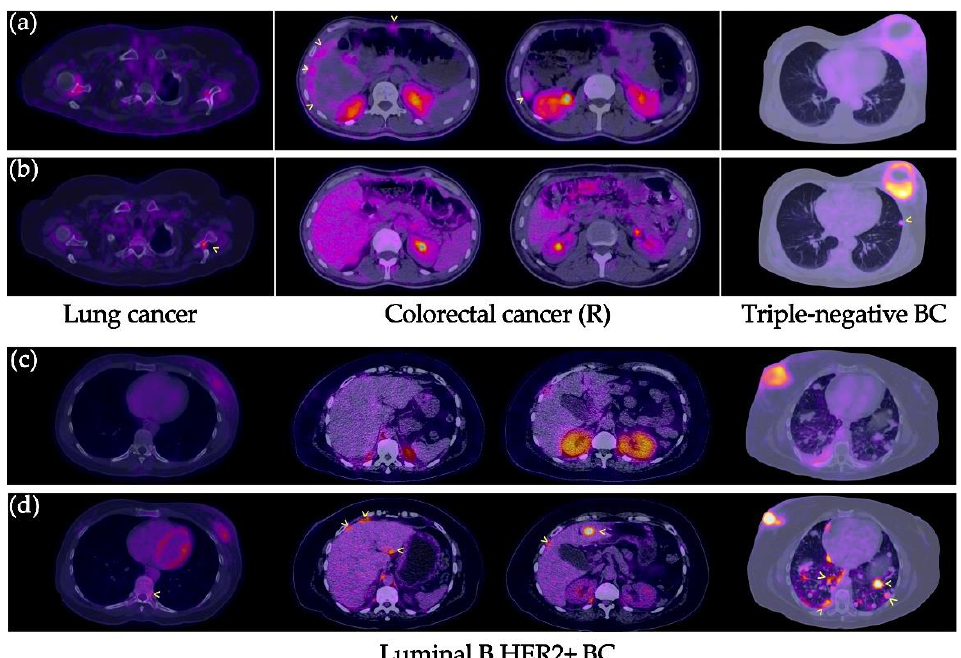
Figure 5. Distant metastases in various types of cancers. ( a , c ) [ 99m Tc]Tc-iFAP SPECT/CT and ( b , d ) [ 18 F]FDG PET/CT. All distant metastatic lesions are hypermetabolic; however, most of them (arrowhead) exhibit decreased or no uptake of [ 99m Tc]Tc-iFAP. In the case of the patient with recurrent colon cancer, areas of diffuse [ 99m Tc]Tc-iFAP uptake were observed in liver subcapsular implants and in the anterior abdominal wall, which were not detected with [ 18 F]FDG. BC: breast cancer. R: recurrence.